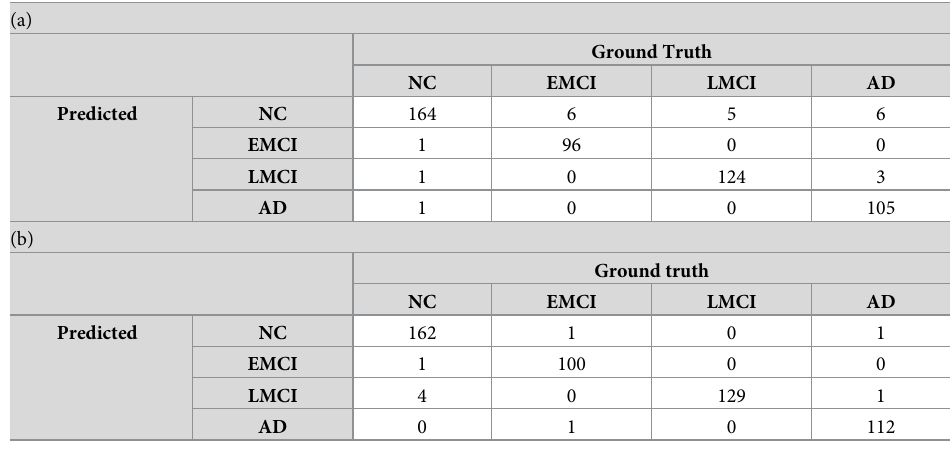
Table 5. Confusion matrix for: (a) Flat multi-classification, (b) Hierarchical multi-classification